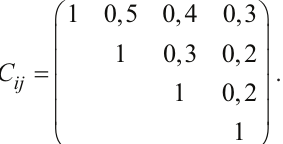
Figs. 7 and 8 present the visualization of solution analogical to Fig. 5 with initial dis- tribution among P1, P2, P3 and P4 is made according to the proportion 4:3:2:1 and according to the structure provided by experts,